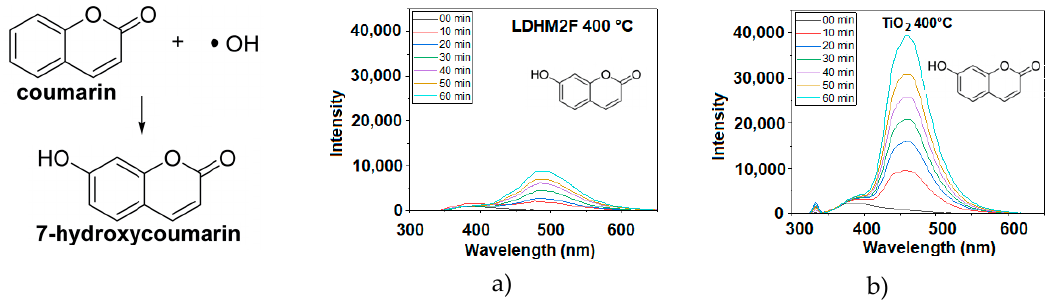
Figure 12. Fluorescence spectra of coumarin employed in the detection of OH • generated by a photocatalyst without air bubbling: ( a ) LDHM2F-400 ◦ C and ( b ) TiO 2 -P25-400 ◦ C.